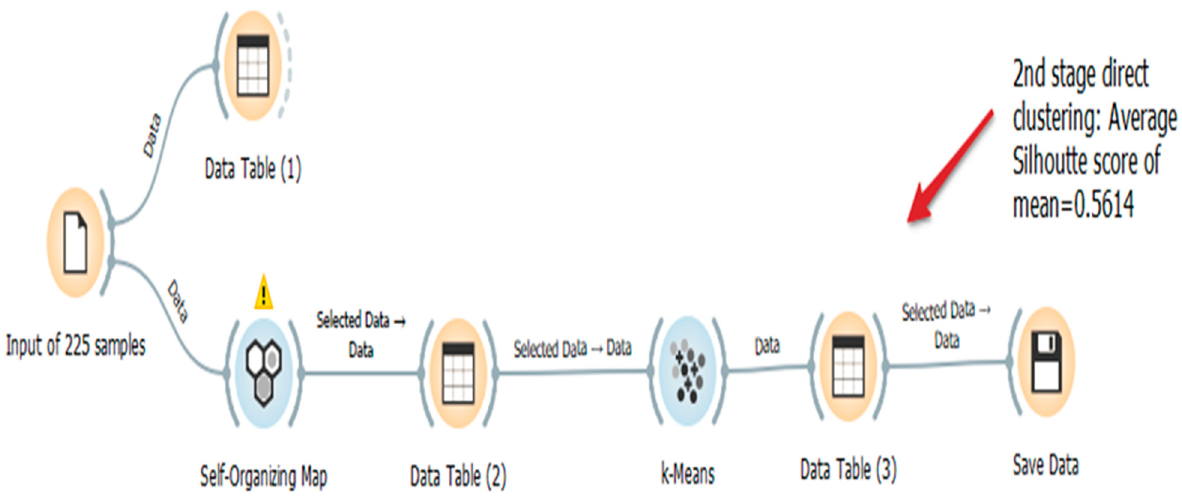
Figure 8. Workflow of best-fitted 2nd-stage indirect clustering model .